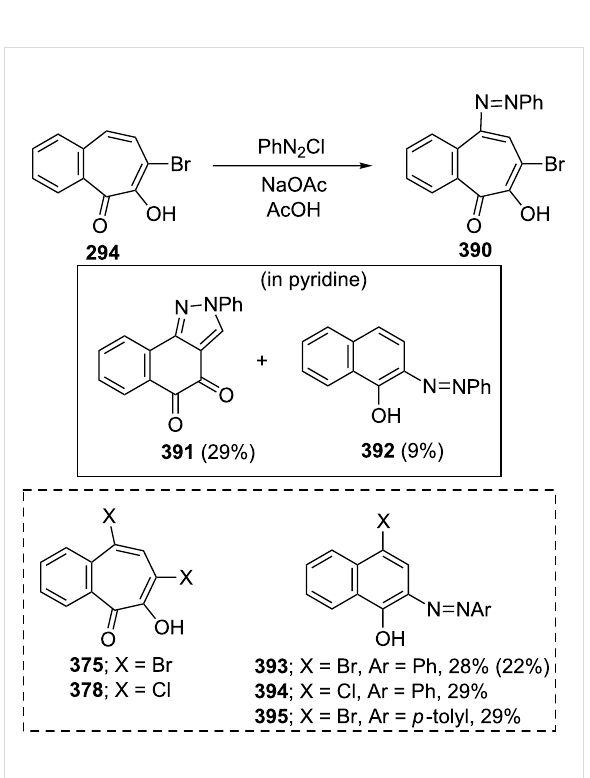
Figure 18: Nitratation and oxidation products of some halobenzotropolenes.